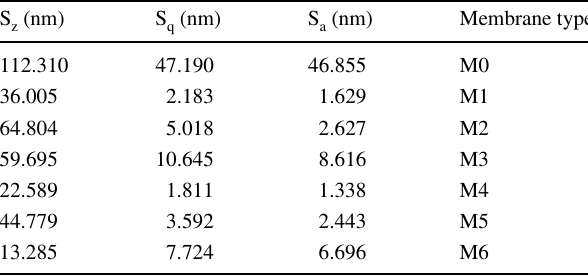
Table 3 The data of surface parameters in the fabricated